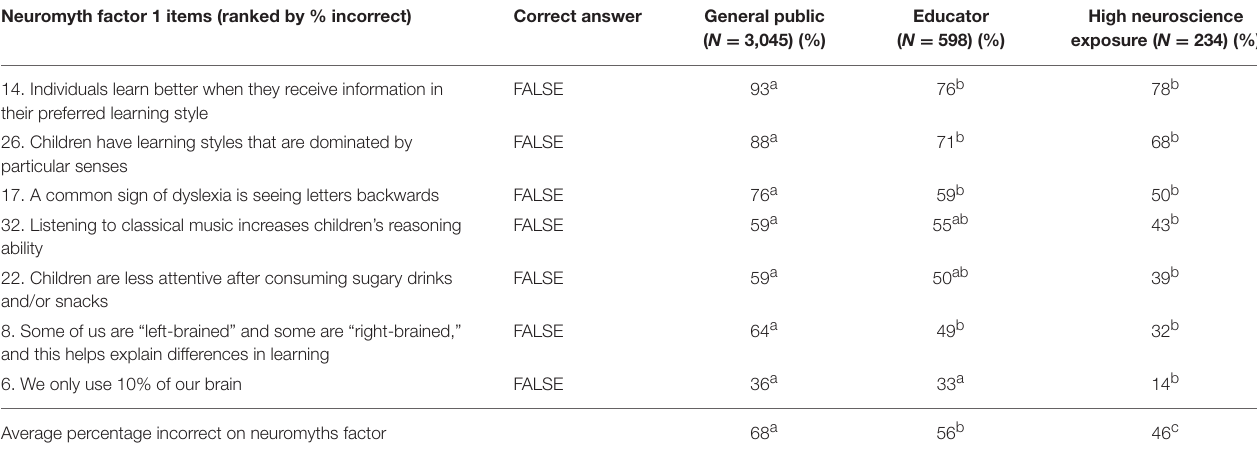
TABLE 5 | Neuromyth endorsement by group. Neuromyth factor 1 items (ranked by %